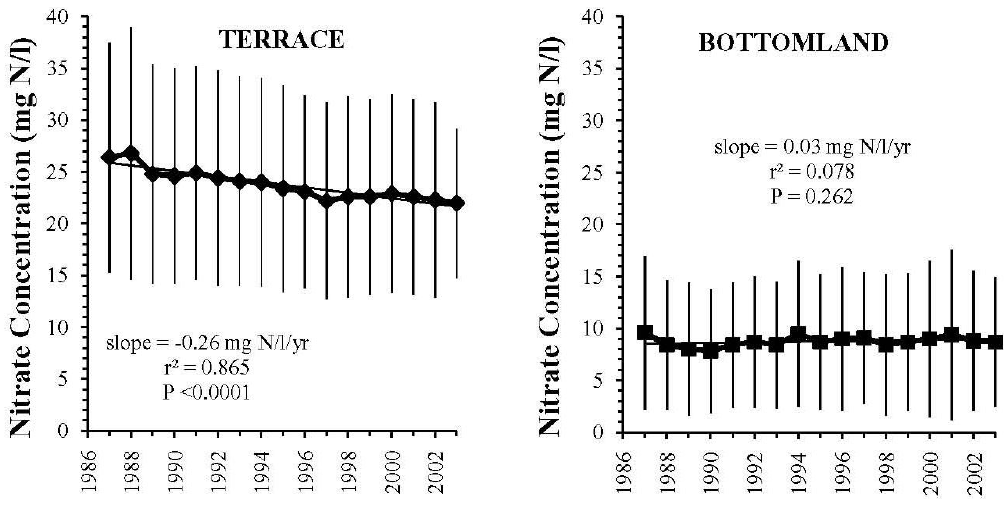
FIGURE 2. Groundwater nitrate concentration trends and rate of change in the primary aquifer beneath the terrace and bottomland. Vertical bars represent one standard deviation from the mean